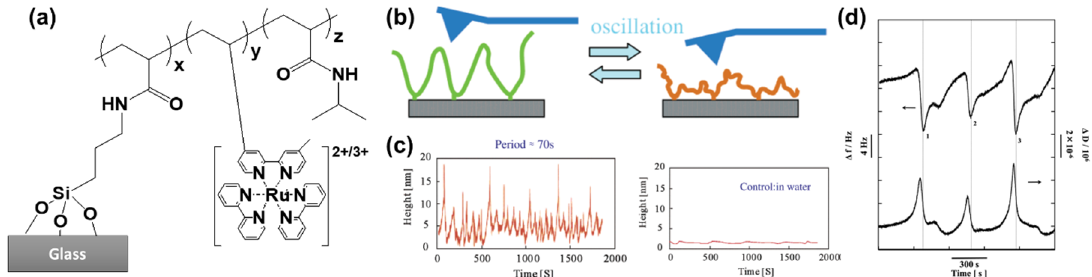
Figure 2. Self-oscillations in surface-grafted polymer chains. ( a ) Structure of the grafted polymer. ( b ) Schematic representation and experimental results for an oscillating chain probed by ( c ) atomic force microscopy (AFM) and ( d ) quartz-crystal microbalance with dissipation (QCM-D). Adapted and reproduced with permission from [57,59], American Chemical Society, 2006 and 2013. Conditions for the BZ reaction: [HNO 3 ] 0.3 M, [NaBrO 3 ] = 0.3 M, [malonic acid] 0.1 M.